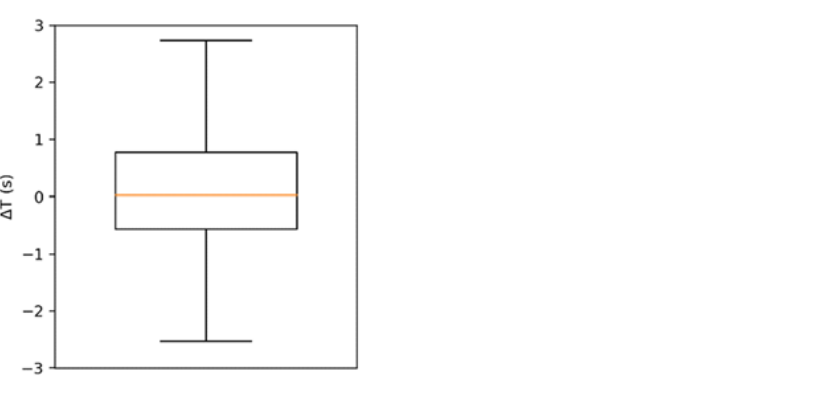
Figure 4. Box plot (outliers not shown) of ∆ T = T ABD − T EMG . Average = 0.22 s, median = 0.03 s, interquartile range = 1.34